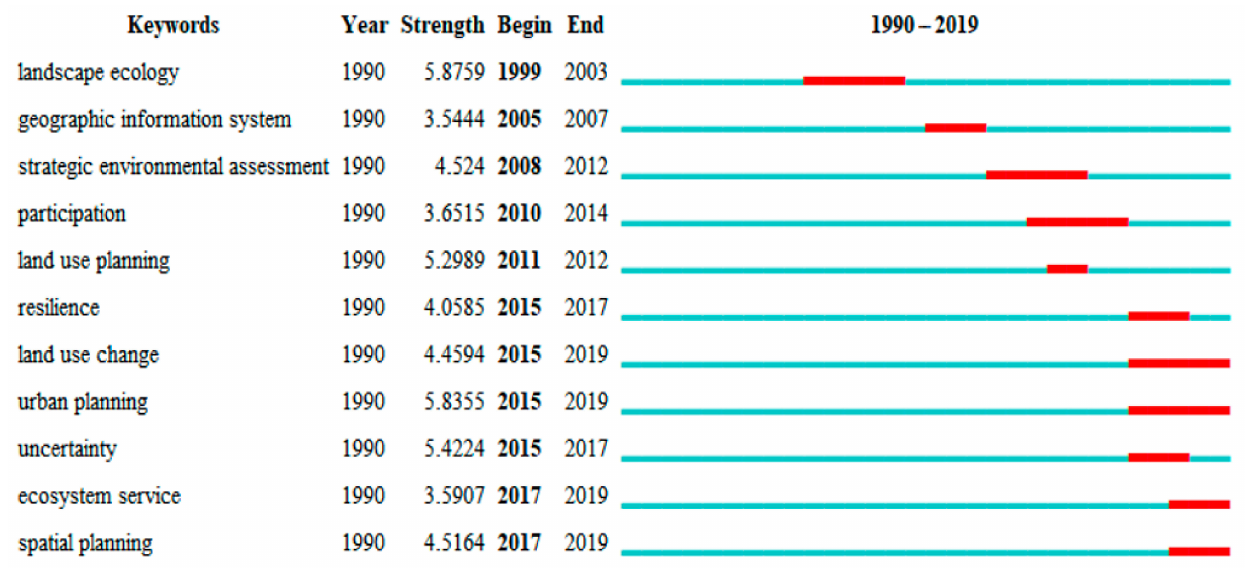
Figure 9. Top 11 keywords with the strongest citation